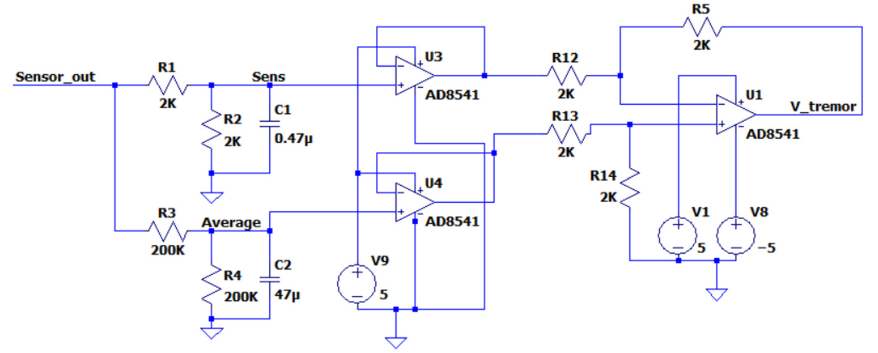
Figure 4. Circuit of the primary conversion of a strain gauge output signal.